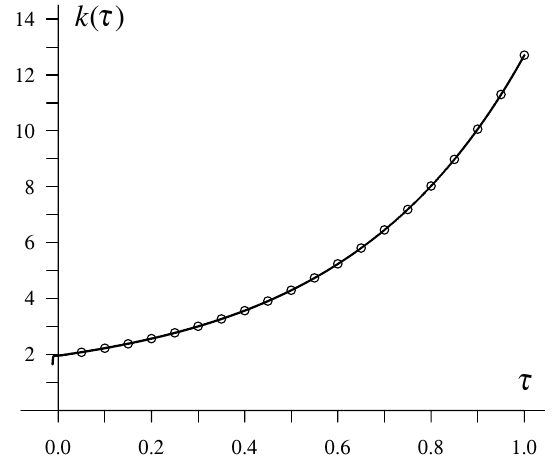
Fig. 1. The function k ( τ ) for − 0 . 012 ≤ τ ≤ 1 and the quan-